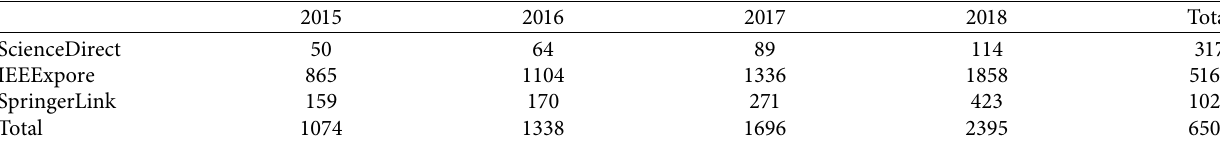
Table 3: Number of papers’ result of the search